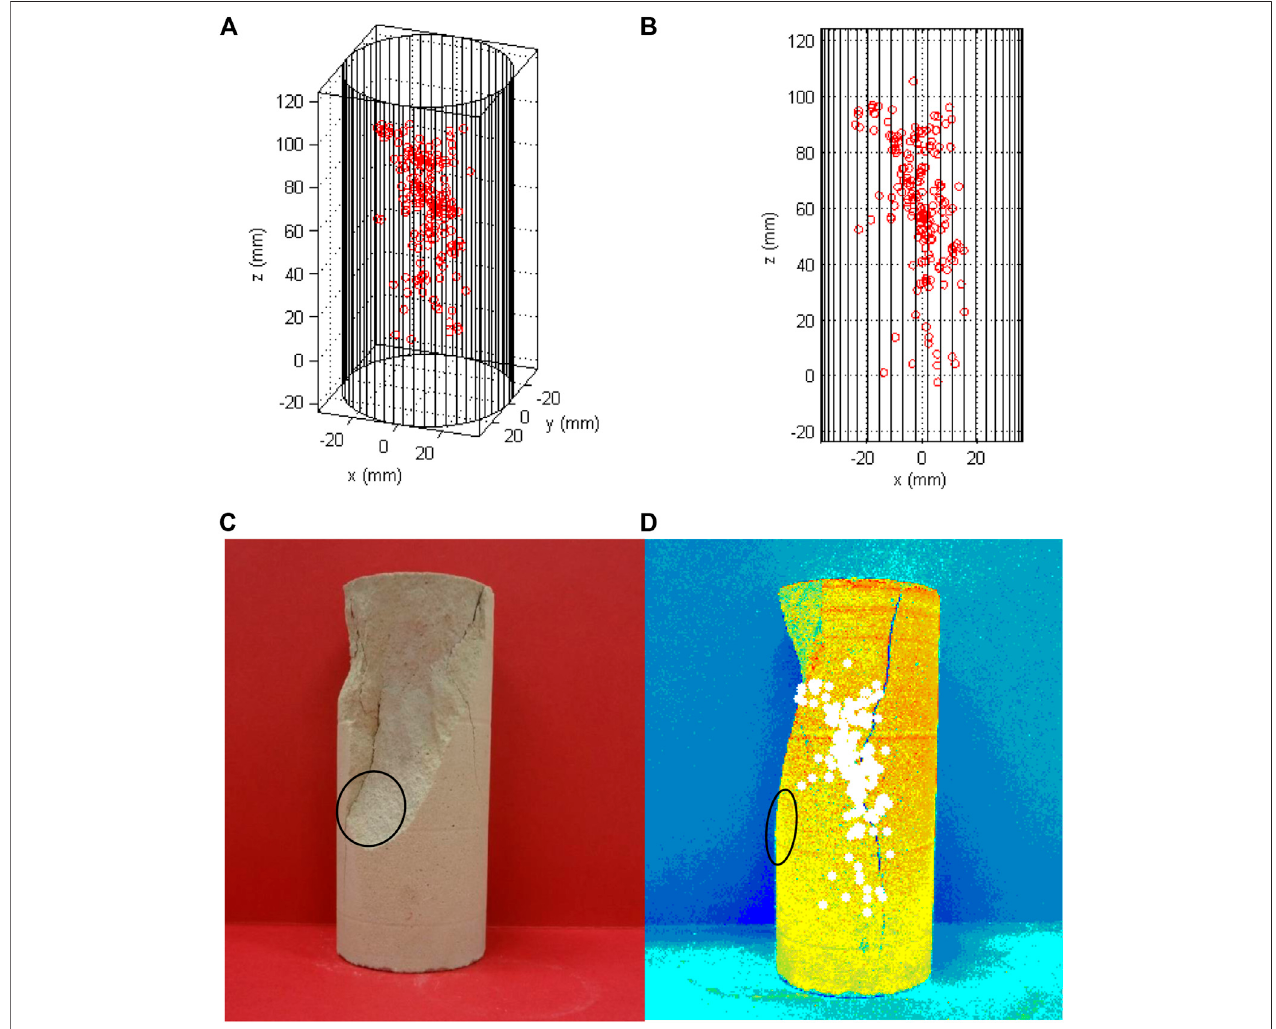
FIGURE 13 | (A) and (B) 3D source locations (red circles) at two different views, (C) photo of the failed specimen, (D) failed specimen photo superimposed by AE source locations (white dots). The parts in the black circles are the same position of the sample.